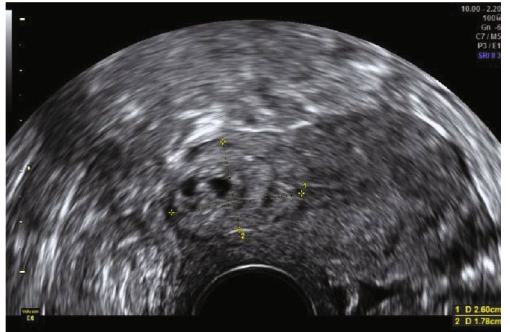
Figure 3: Transvaginal ultrasonographic study of the pelvic- abdominal region showing a retroverted uterus, with a biometry of 64mm x 38mm. The uterine morphology was regular, and the myometrial ultrasound pattern was homogeneous. Ultrasound signs of cavitary pathology were not observed. The endometrial thickness was 2mm. At the level of the cesarean section scar, a 29x16 mm nodular image was observed, with a heterogeneous pattern.